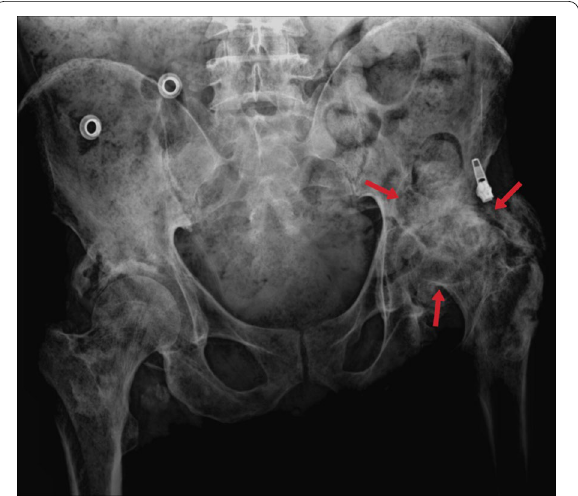
Fig. 50 Pelvic X-ray of a 53-year-old female. The left hip joint sequela of TB is characterized by degenerative arthritis (arrows)